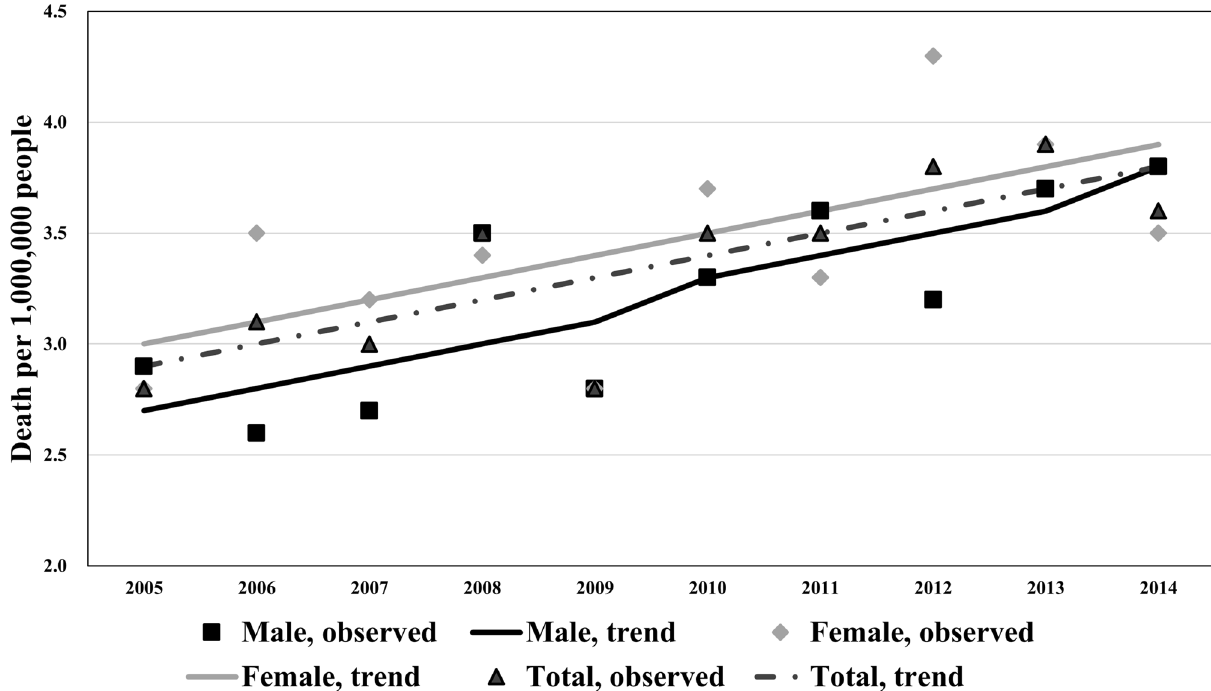
Figure 3. Trends in age-adjusted rates of Creutzfeldt–Jakob Disease-associated death by sex, 2005–2014. The trends of age-adjusted CJD mortality rates in the entire period by sex are shown. Average annual percentage change (%) [95% confidence interval] in total, male, and female were 3.2* [1.4, 5.1], 3.7* [1.3, 6.0], and 2.9 [− 0.1, 5.9], respectively. *Significantly different from zero ( p < 0.05).